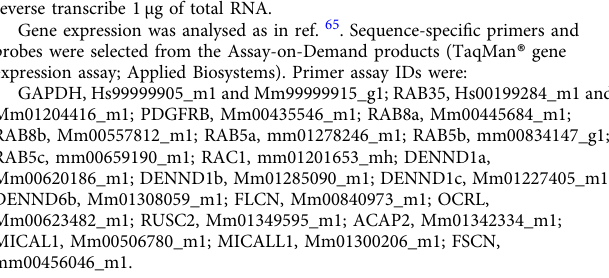
Fig. 7 Molecules acting in concert with RAB35 to promote Dorsal Ruf fl es formation. a Schematic representation of the signalling pathway leading to CDR formation. b RAB5 and RAC are required for RAB35-dependent CDR formation but PDGFRB is dispensable. pSLIK-HA-RAB35-human-MEFs were silenced for Pdgfrb , or Rab5 or Rac1 and treated or not with doxycycline to induce the transgene expression. CDR formation was monitored by time-lapse phase contrast microscopy. Still phase contrast images from time-lapse sequence (Supplementary Movie 13) are shown. Red arrows indicate CDRs. Scale bar, 100 µ m. The number of CDRs/cell/h was reported as mean ± SEM (>30 cells/condition, three independent experiments). **** p < 0.0001; ns not signi fi cant, paired Student ’ s t -test. The silencing of genes was veri fi ed by qRTPCR. c Silencing of Rab35 GEFs or effectors. MEF cells were interfered for the indicated Rab35 GEFs or effectors and tested for their ability in forming CDRs upon PDGF stimulation. Representative Phalloidin-stained images are reported for each experimental condition. Scale bar, 50 µ m. CDRs were manually counted and normalized against the scrambled sample. Data are